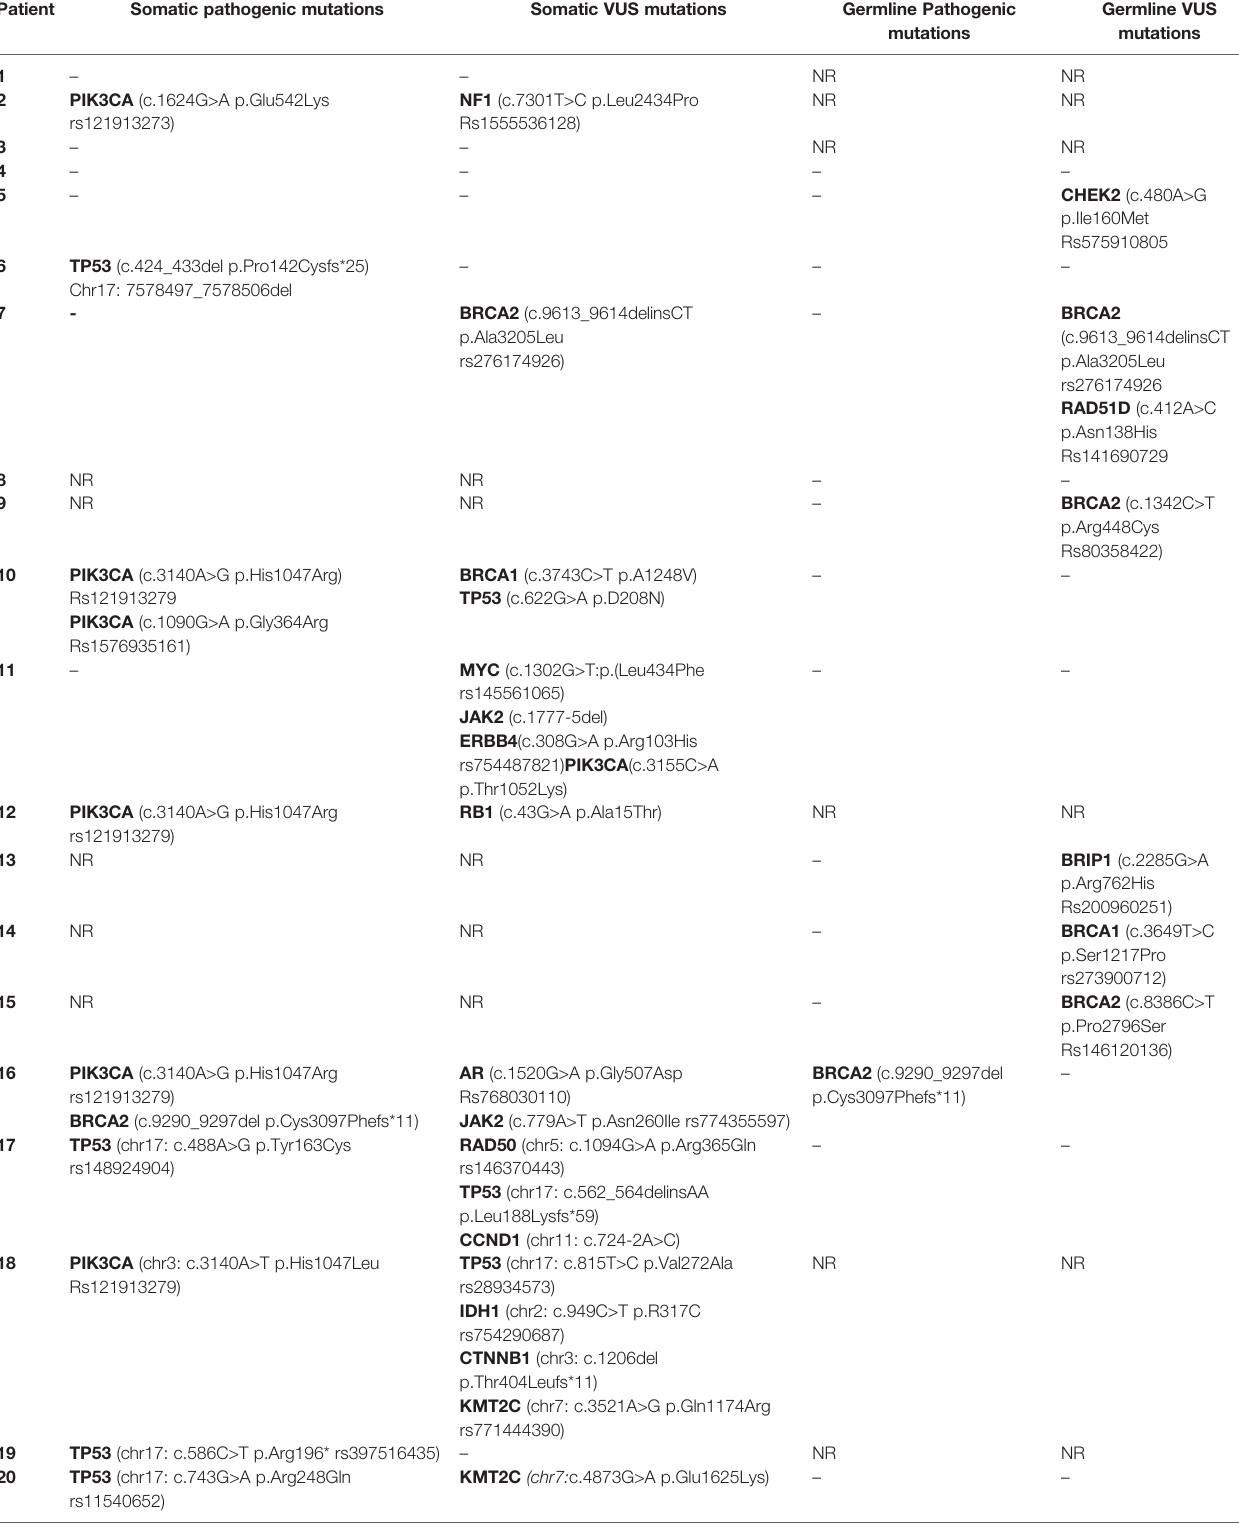
TABLE 4 | Somatic and germline mutations of young women (<40) with breast cancer as determined by